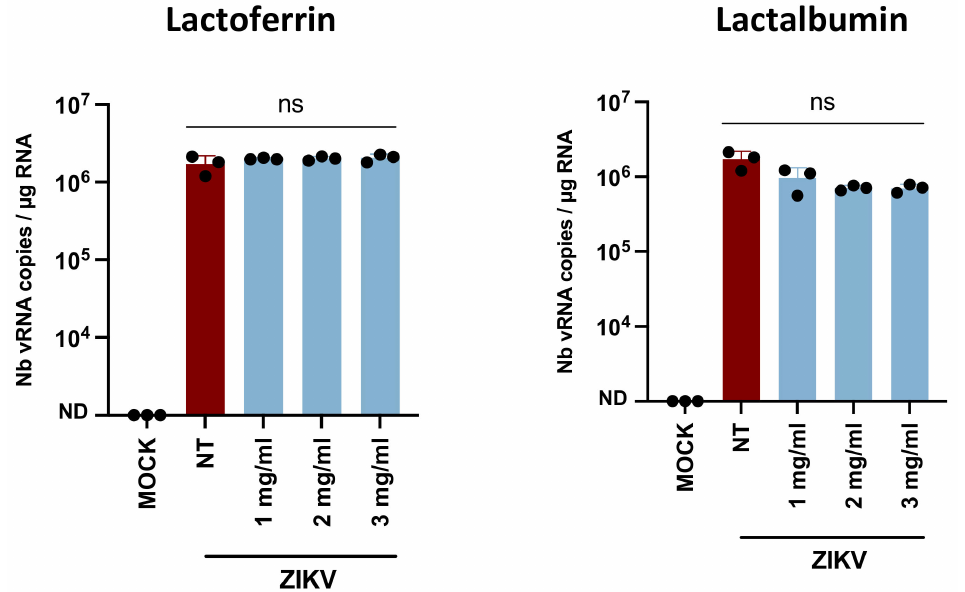
Figure 5. Lactoferrin and lactalbumin are not antiviral against ZIKV. ZIKV H/PF13 particles were incubated with culture medium (NT), lactoferrin, or lactalbumin (at physiological concentrations of human milk) for 1 h at 37 ◦ C before infection of Caco-2 cells (MOI 1). At 48 h post-infection,